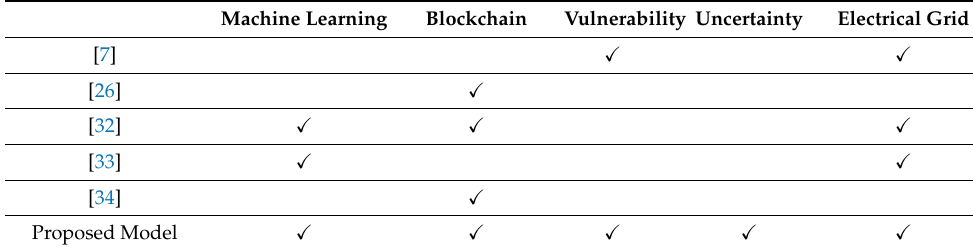
Table 1. Categorization of the difference